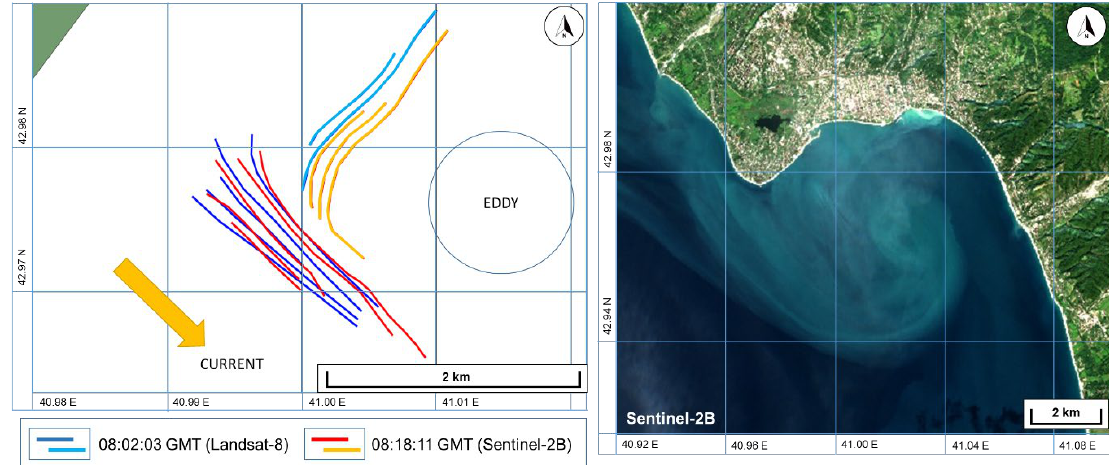
Figure 12. Optical satellite images obtained sequentially with a time interval of ~16 min on 4 October 2020, above —Landsat-8, below —Sentinel-2. The results of the registration of surface manifestations of internal waves showed on the right .